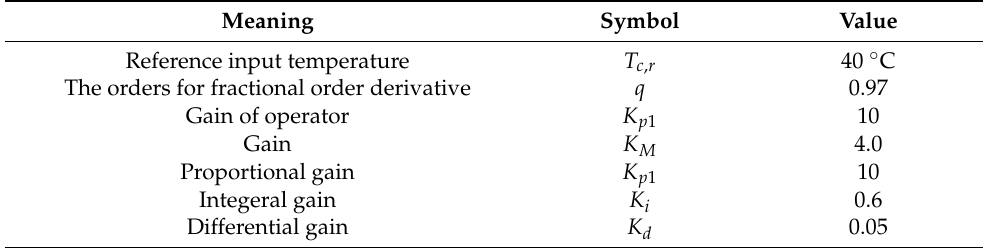
Table 6. Tuning parameters for PID Controller with operator controller.